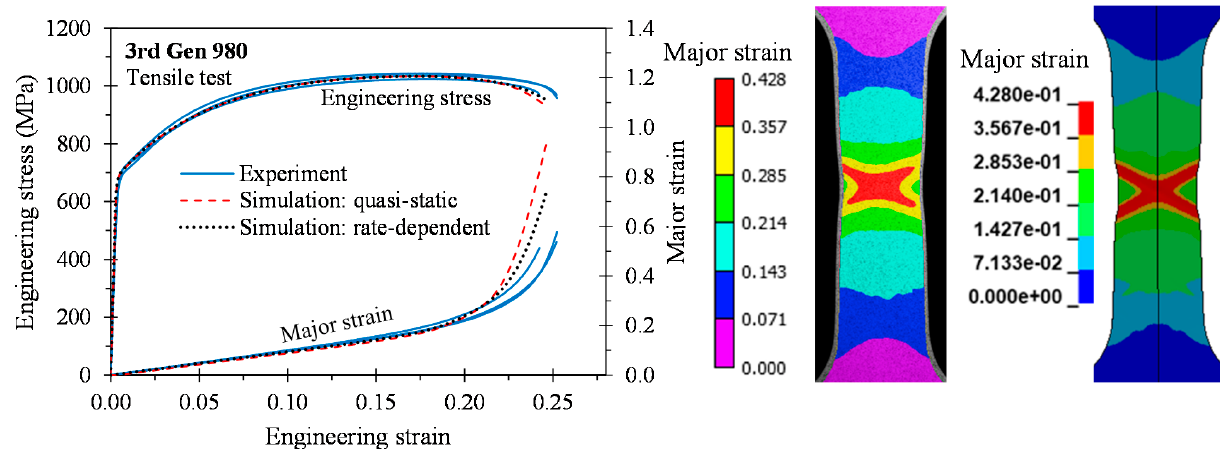
Figure 16. Comparison of the global and local response in 3D tensile simulations for the 3rd Gen 980.